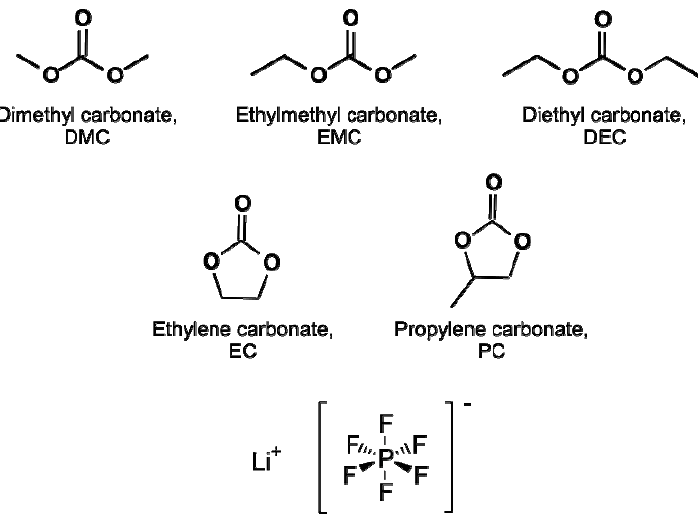
Figure 1. Structures of six of the most important linear and cyclic organic carbonates and the conducting salt lithium hexafluorophosphate for the electrolyte system in lithium ion batteries [60,61].